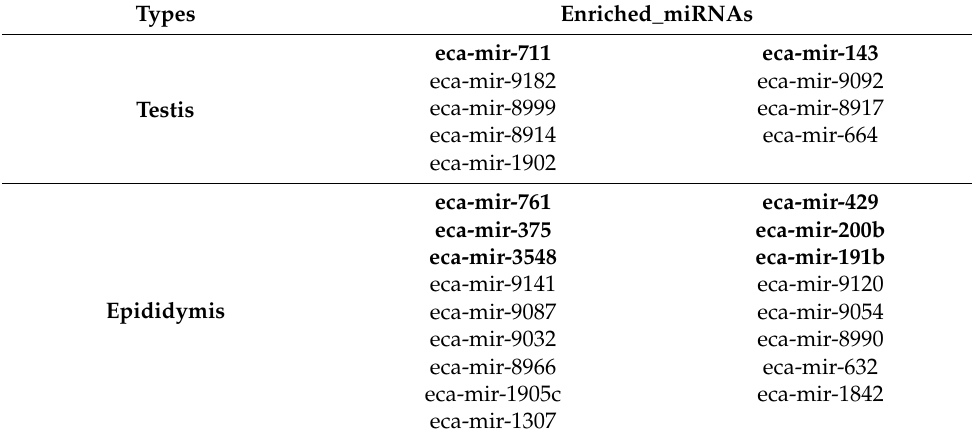
Table 1. Annotation of enriched-miRNAs in testis and epididymis tissues of donkey.